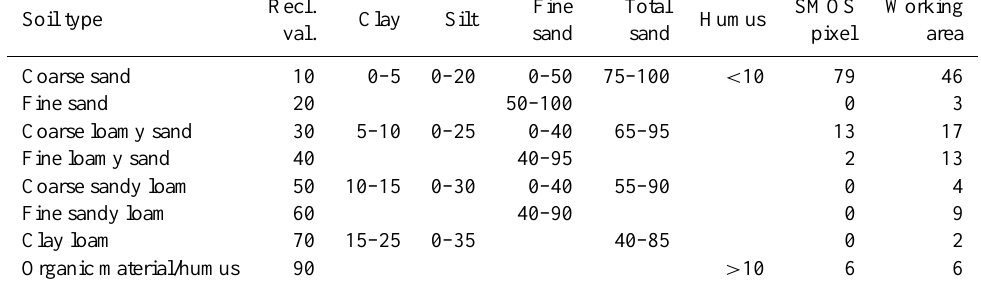
Table 1. Topsoil information (0–20cm depth): soil type, class numbers used in the sum-up to composite classes, textural fractions [%] of clay ( < 2µm), silt (2–20µm), fine sand (20–200µm) and total sand (20–2000µm), organic matter content (humus, 58.7% C) [%], and respective fractions [%] of soil type contained in the SMOS pixel and working area around Discrete Global Grid node 2002029. Recl.